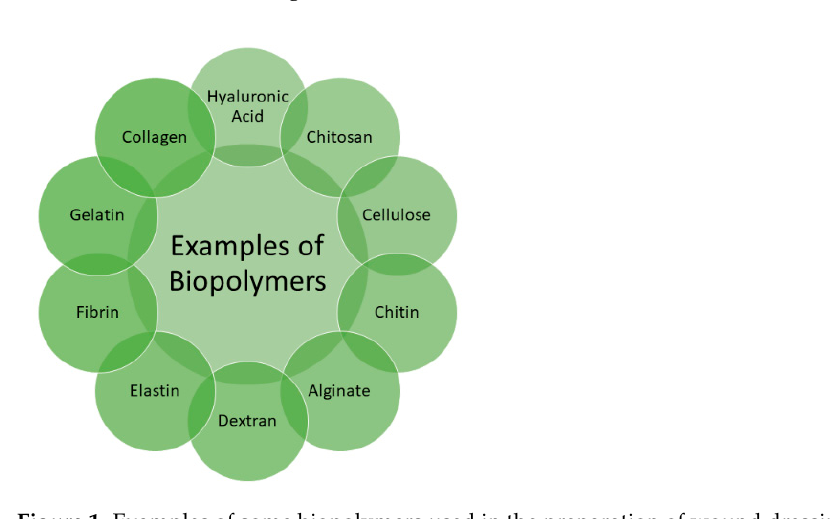
Figure 1. Examples of some biopolymers used in the preparation of wound dressings.